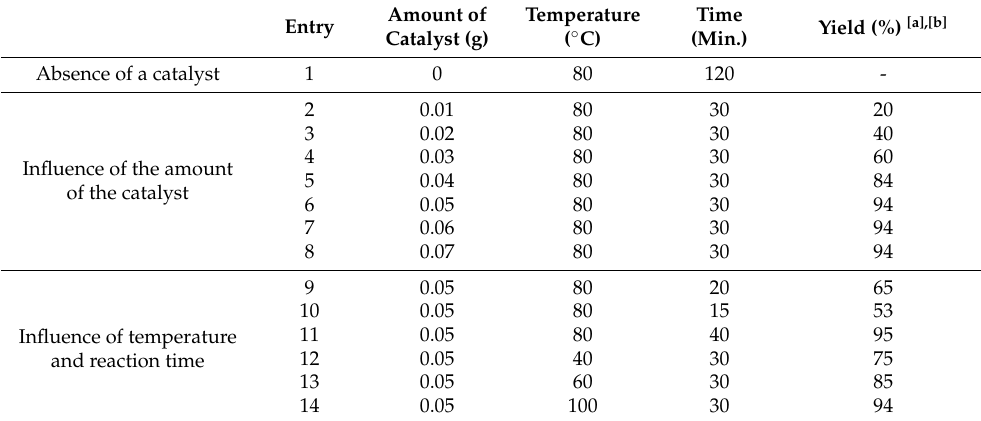
Table 1. Optimization of reaction conditions for the synthesis of 2-amino-3-cyanopyridine 5a .